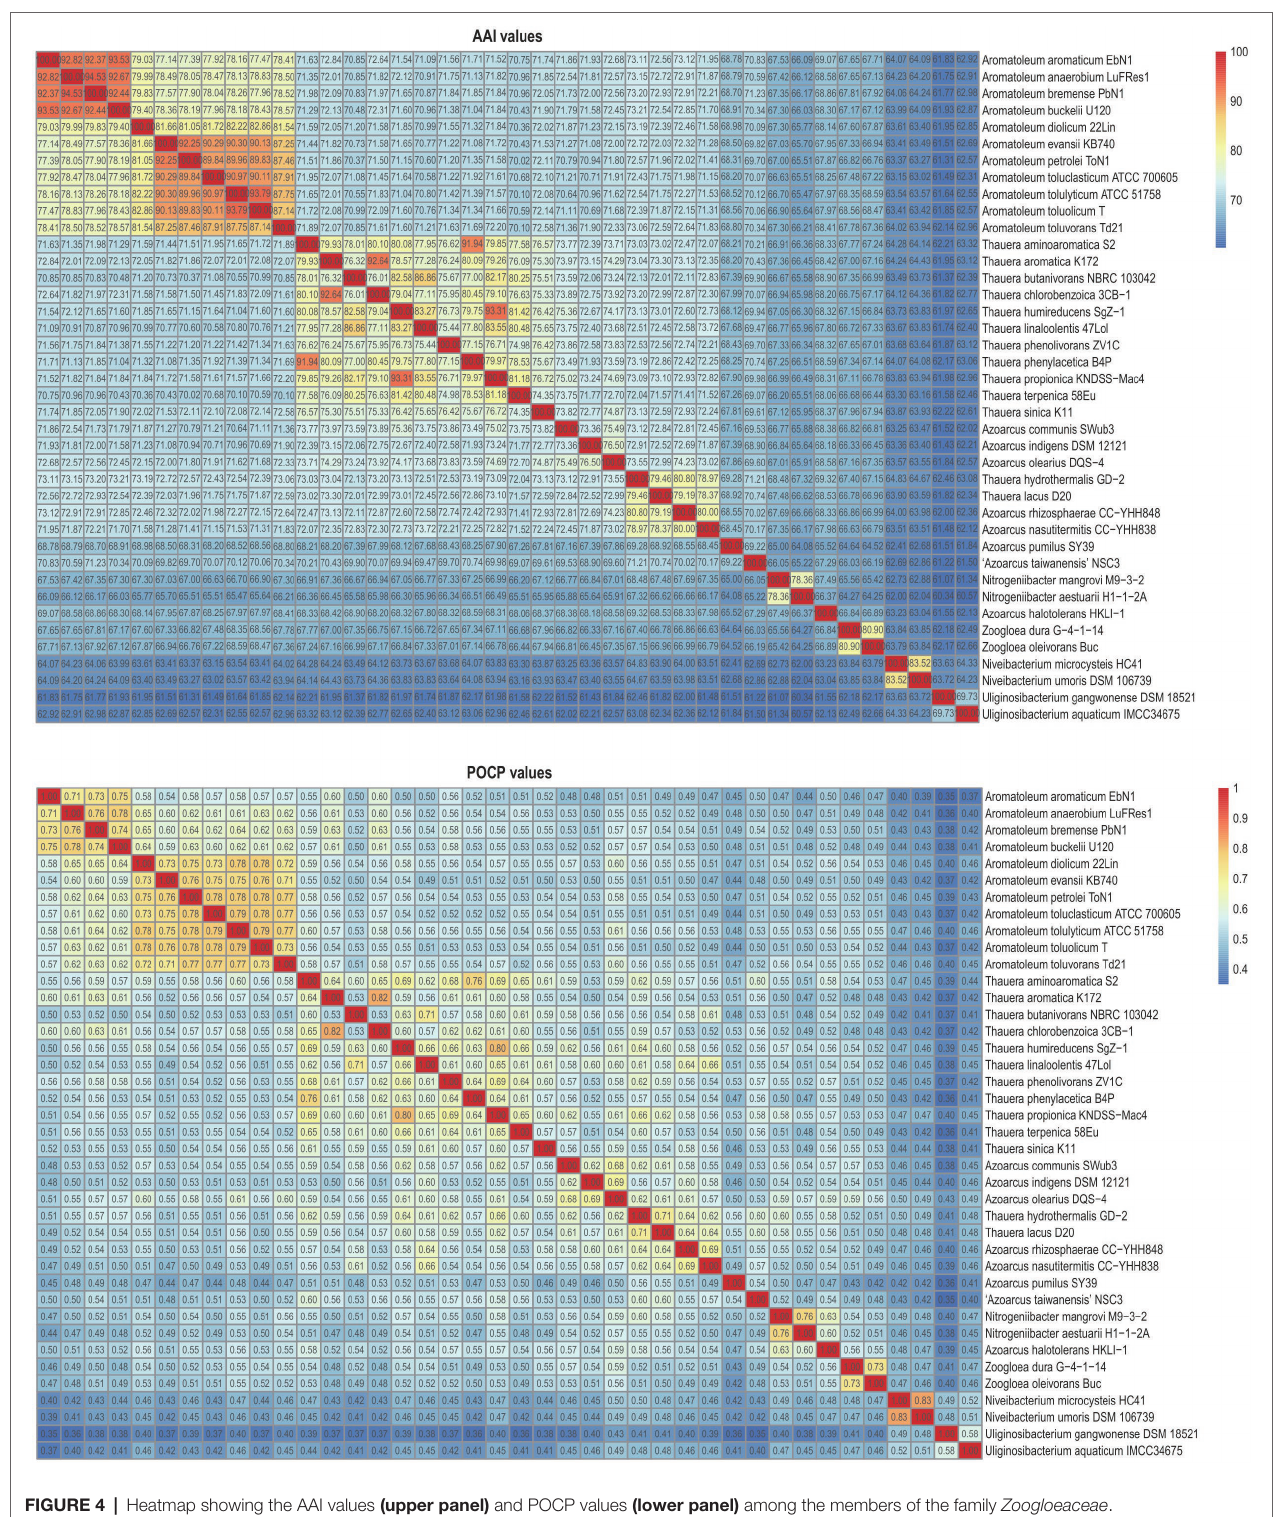
stain-negative and rod-shaped. Growth occurs between 15 and 40 ° C with an optimum at 35 ° C, at 0–4% NaCl (w/v) with an